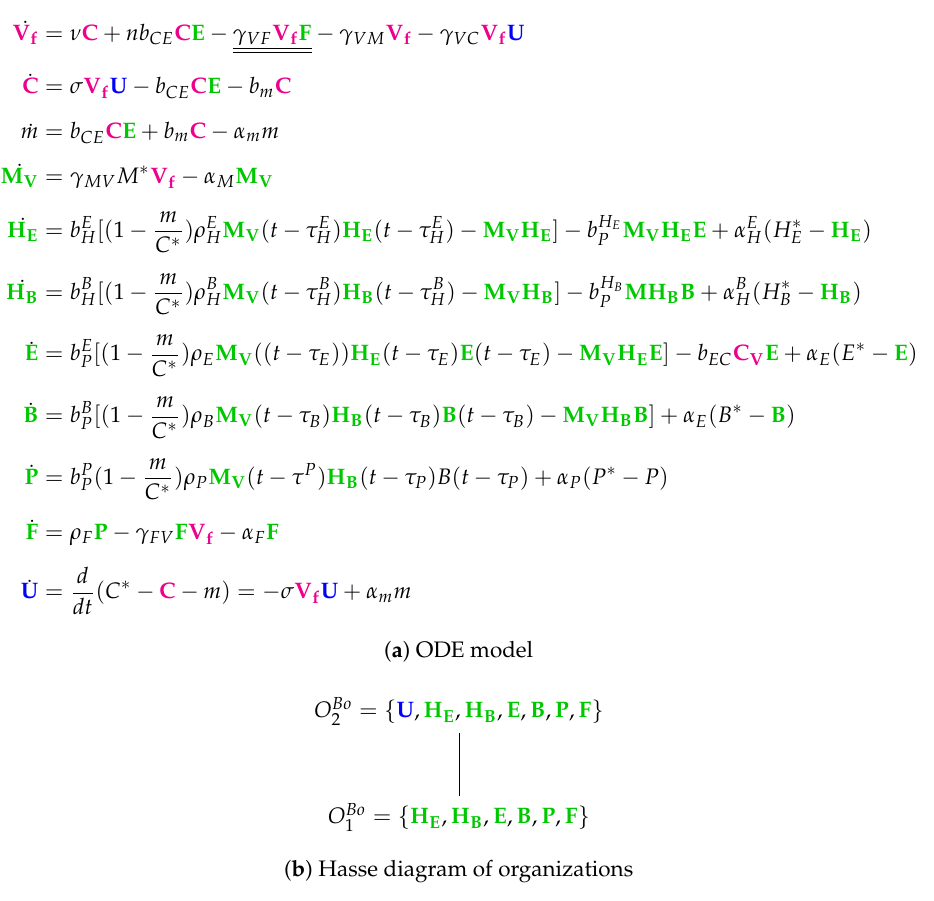
Figure 13. The Bocharov Model [30] with 10 variables: infective IAV particles ( V f ), IAV-infected cells ( C ), destroyed epithelial cells ( m ), stimulated macrophages ( M V ), activated helper T cells providing proliferation of cytotoxic T cells ( H E ), activated helper T cells providing proliferation and differentiation of B cells B ( H B ), activated CTL ( E ), B cells ( B ), plasma cells ( P ), antibodies to IAV ( F ), and uninfected epithelial cells ( U ). Note that, for clarity, we have added U as a state variable, which is only implicitly represented as U = C ∗ − C − m in the original model by Bocharov et